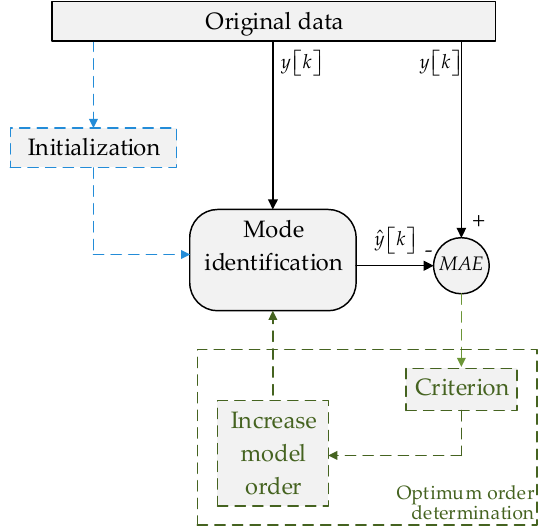
Figure 1. Mode identification procedure flowchart.